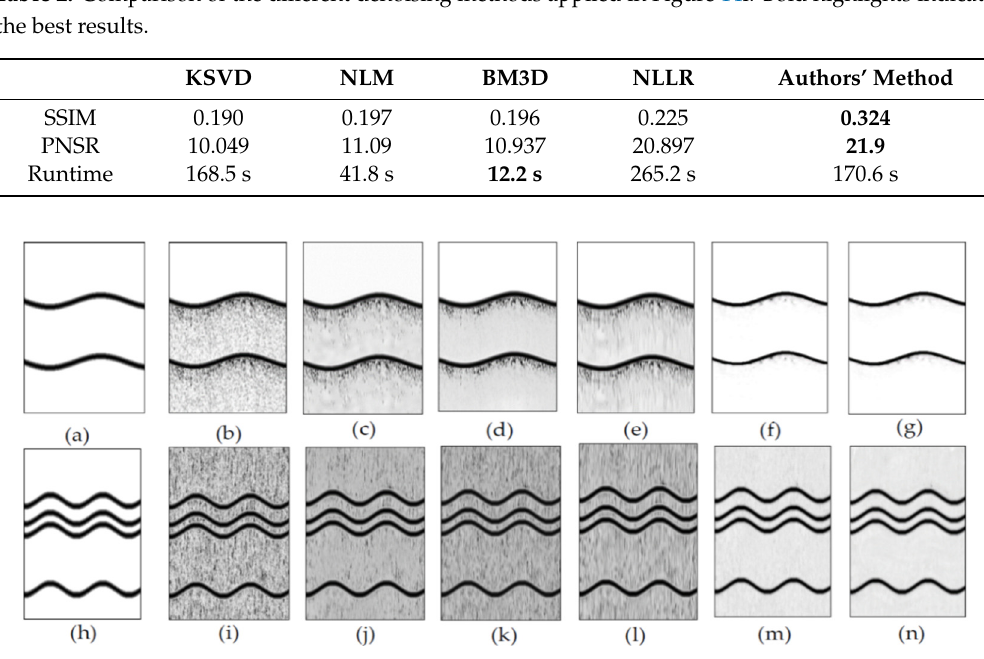
Figure 15. Filtering results based on synthetic data: ( a ) shows the clean synthetic SBP image, ( b ) is the synthetic polluted SBP image, ( c – g ) are the filtered results using KSVD, NLM, BM3D, NLLR, and the proposed method, ( h ) is the clean synthetic SBP image, ( i ) is a synthetic polluted SBP image, ( j – n ) show the filtered results using KSVD, NLM, BM3D, NLLR, and the proposed method. Table 3. Comparison of the di ff erent denoising methods applied in Figure 15b. Bold highlights indicate the best